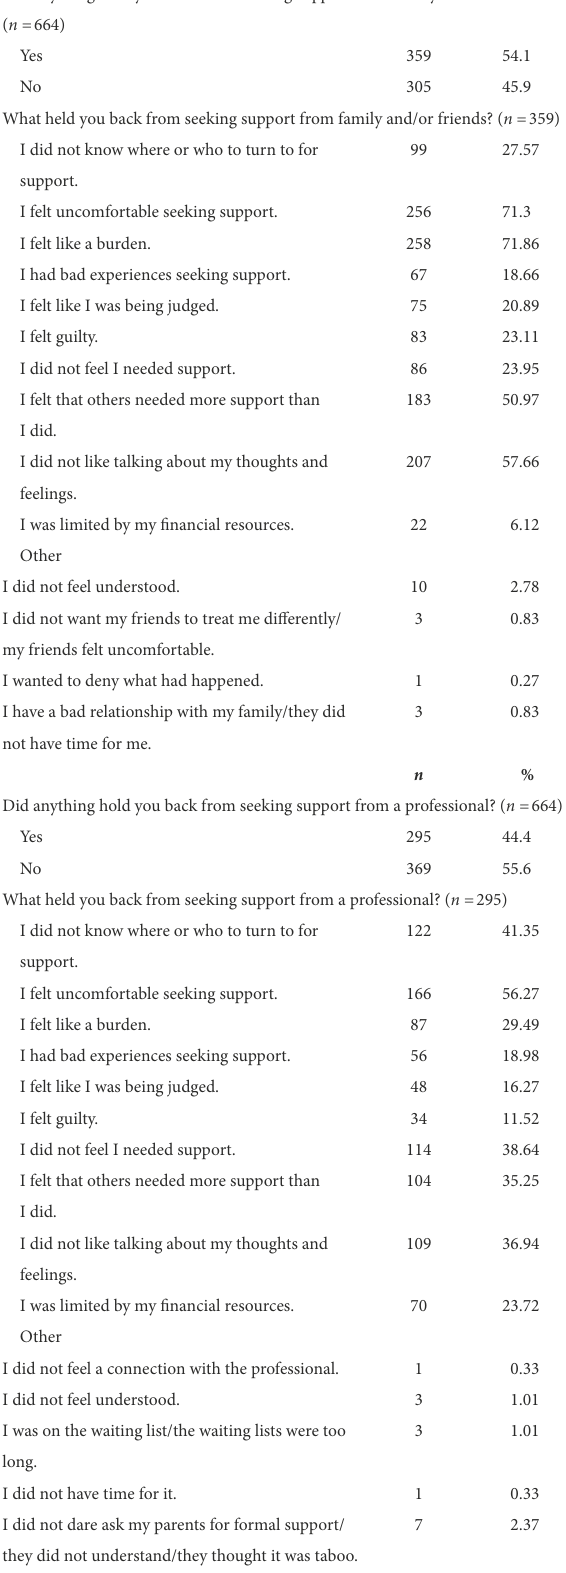
TABLE 2 Barriers in seeking social and formal